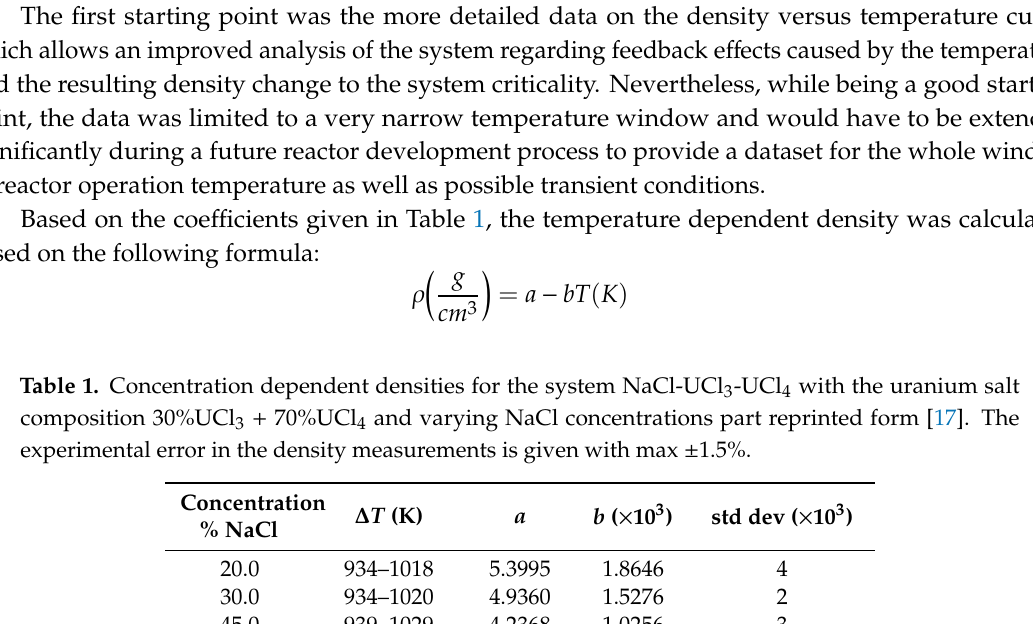
Table 1. Concentration dependent densities for the system NaCl-UCl 3 -UCl 4 with the uranium salt composition 30%UCl 3 + 70%UCl 4 and varying NaCl concentrations part reprinted form [17]. The experimental error in the density measurements is given with max ±1.5%.